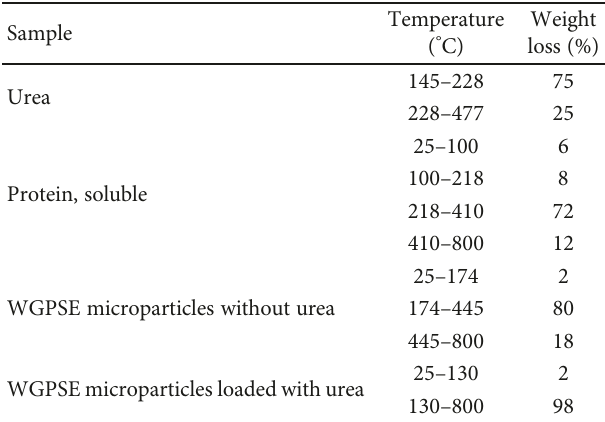
Figure 8: TGA curves of WGPSE microparticles loaded with urea, WGPSE microparticles without urea, WGPSE, and urea. Table 4: Thermogravimetric analysis (TGA) of urea, wheat-gluten proteins soluble in ethanol (WGPSE) (gliadins, mainly), WGPSE microparticles without urea, and WGPSE microparticles loaded with urea.